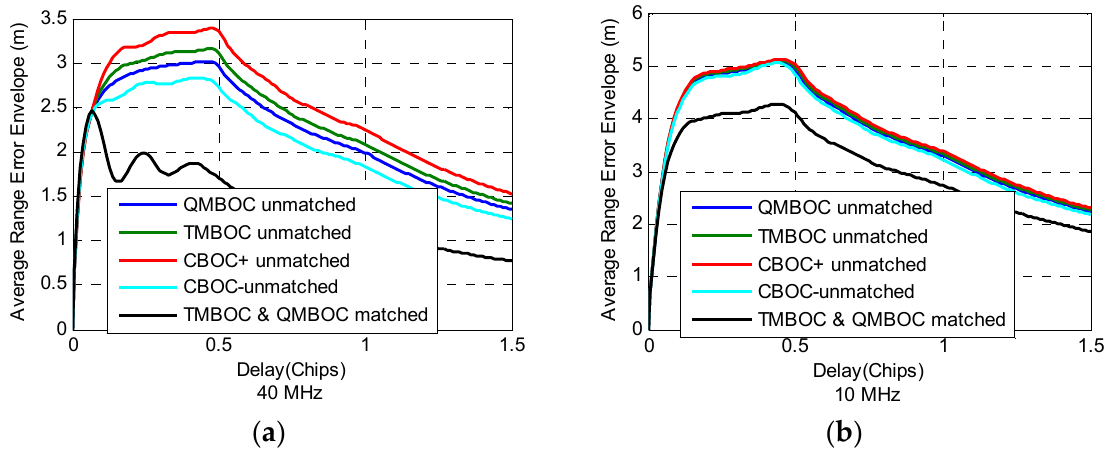
Figure 9. Average range error envelope of MBOC(6,1,1/11), under matched receiving and BOC 11 -like unmatched receiving. ( a ) Double-sided receiving bandwidth is 40 MHz; ( b ) Double-sided receiving bandwidth is 10 MHz. MDR is − 5 dB.